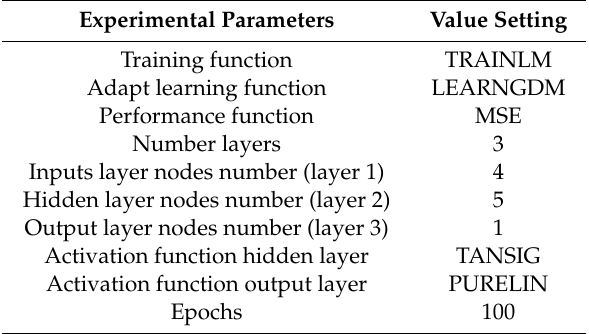
Table 9. Default settings of Back Propagation (BP).